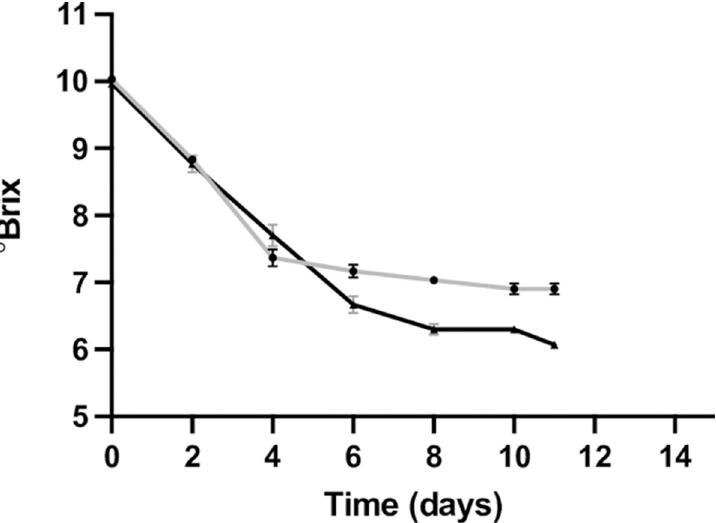
Fig 1. Fermentation profiles of the Group I CBS1538 and Group II W34/70 strains. Fermentations were carried out in 10% Wort at 13˚C in 15 mL cylindrical tubes. Sugar consumption was measured with a Brixometer (˚Brix). CBS1538: grey line,W34/70, black line. Error bars represent the standard deviations from the mean of triplicate fermentations. Supporting data is available in the supporting information file S1 Data.